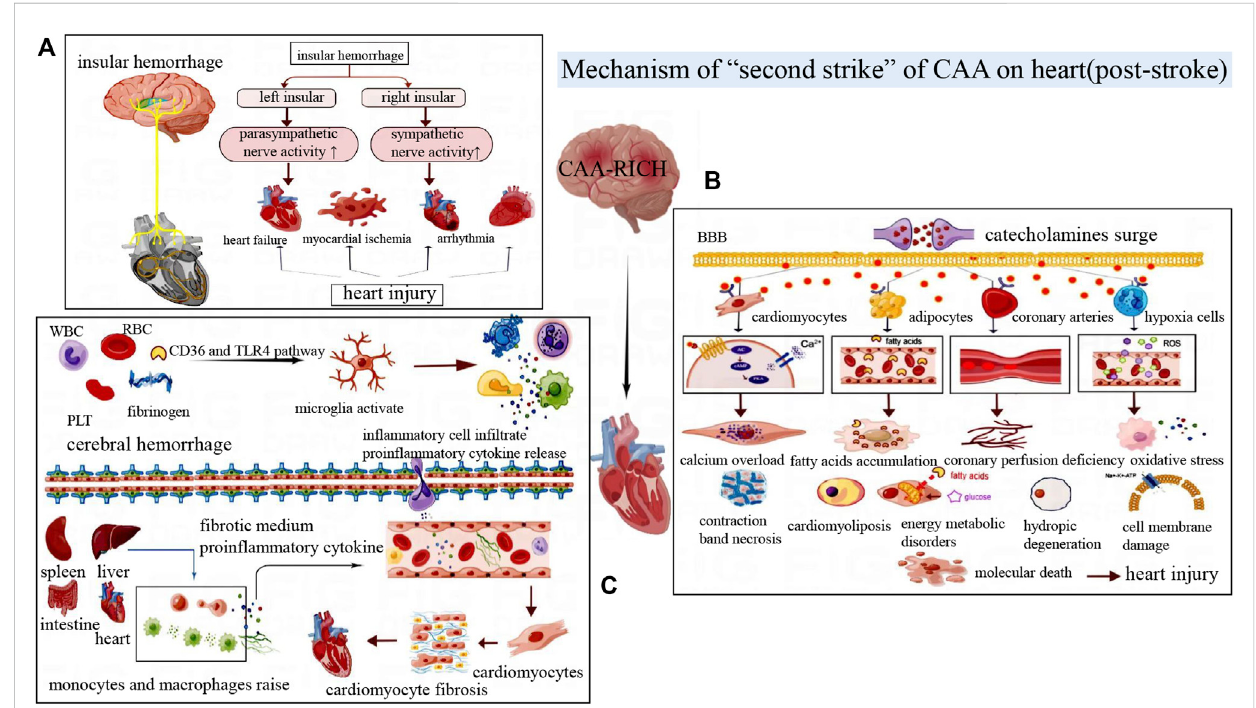
FIGURE 4 (A) The left and right insular cortexes have different lateralizing effects on the autonomic nervous system. Damage to the right insular cortex often activates the sympathetic nerve, while damage to the left insular cortex often activates the parasympathetic nerve, resulting in different cardiac injury manifestations. (B) Post-stroke catecholamines surge, which acts on cardiomyocytes, adipocytes, in fl ammatory cells and blood vessels, then leading to myocardial contraction band necrosis, myocardial steatosis, vasoconstriction myocardial ischemia, excessive oxidative stress and other manifestations of cardiac injury. (C) The release of blood components activates microglia, followed by the release of in fl ammatory factors and cytokines that lead to a systemic in fl ammatory response by damaging the blood-brain barrier. Mononuclear macrophage recruitment in the liver, spleen, and intestine aggravates cardiac in fl ammation and eventually leads to myocardial fi brosis and other